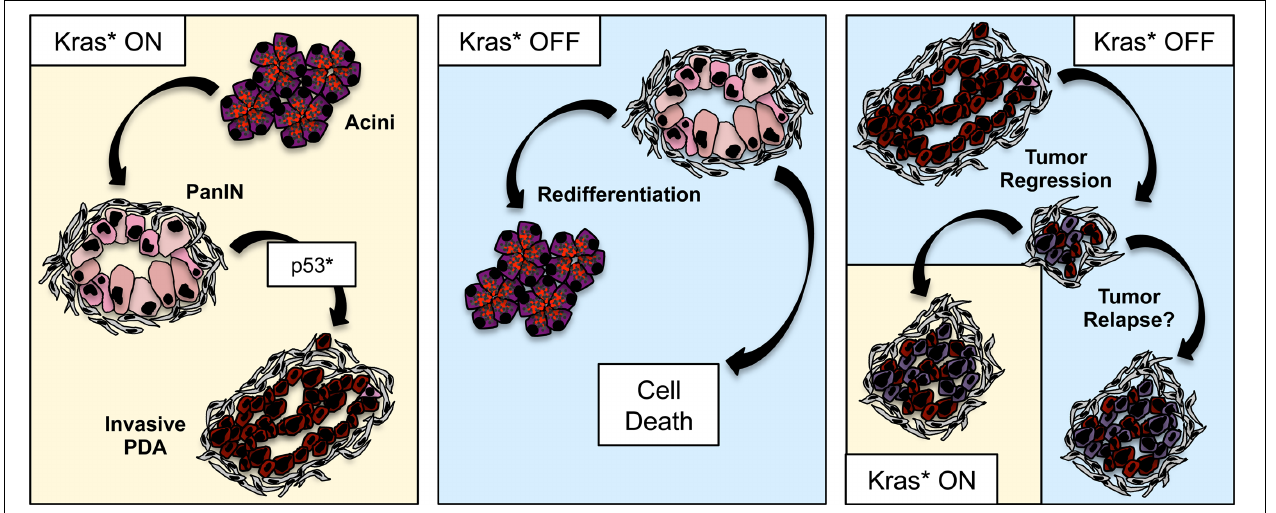
FIGURE 1 | Oncogenic Kras in pancreatic cancer progression and maintenance. Oncogenic Kras drives PanIN formation and—in combination with loss or mutation of tumor suppressors such as p53—progression to invasive adenocarcinoma. Inactivation of oncogenic Kras at the PanIN stage leads to regression of the lesions, through a